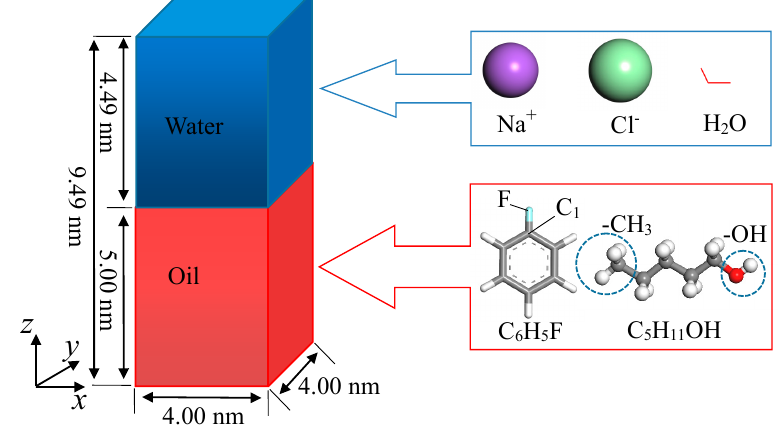
Figure 1. Model and molecular structure of the oil–water interface. Table 1. The number of microscopic particles contained in the various oil–water systems.